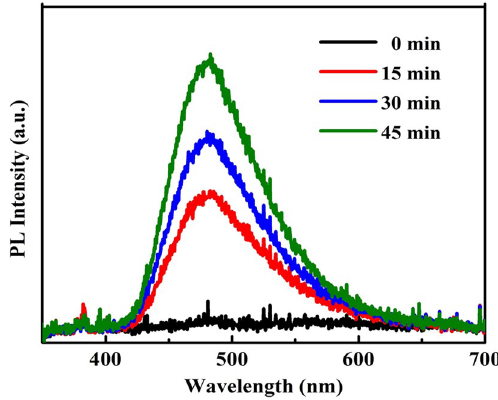
Figure 8. PL spectra for photodegradation of MB dye using SiO 2 @ α -Fe 2 O 3 /ZnO nanocomposites in the presence of terephthalic acid at different time intervals under visible light irradiation.